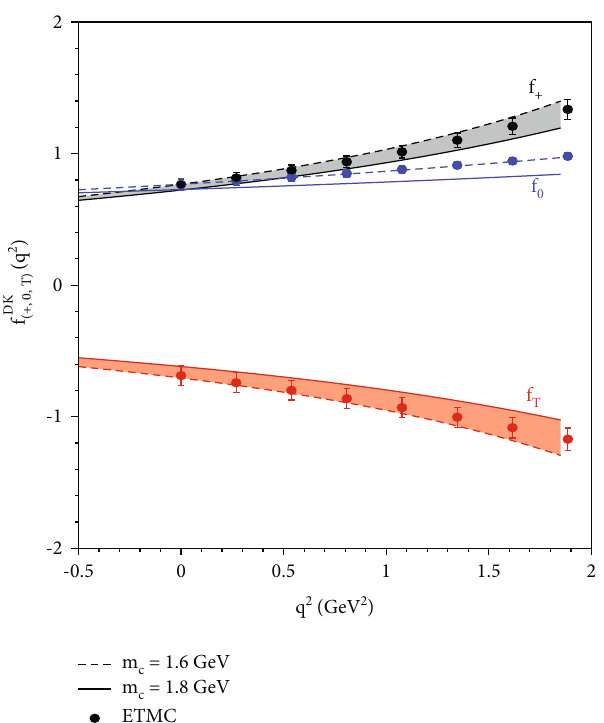
, f , f ) + 0 T Figure 3: Di ff erential decay rate for the D ⟶ π e ν compared with the experimental data from the BABAR [67, 68] (black circles), CLEO [69] (blue squares), and BES III [13, 14] for neutral D 0 (red diamonds) and charged D + with the account of isospin factor (green